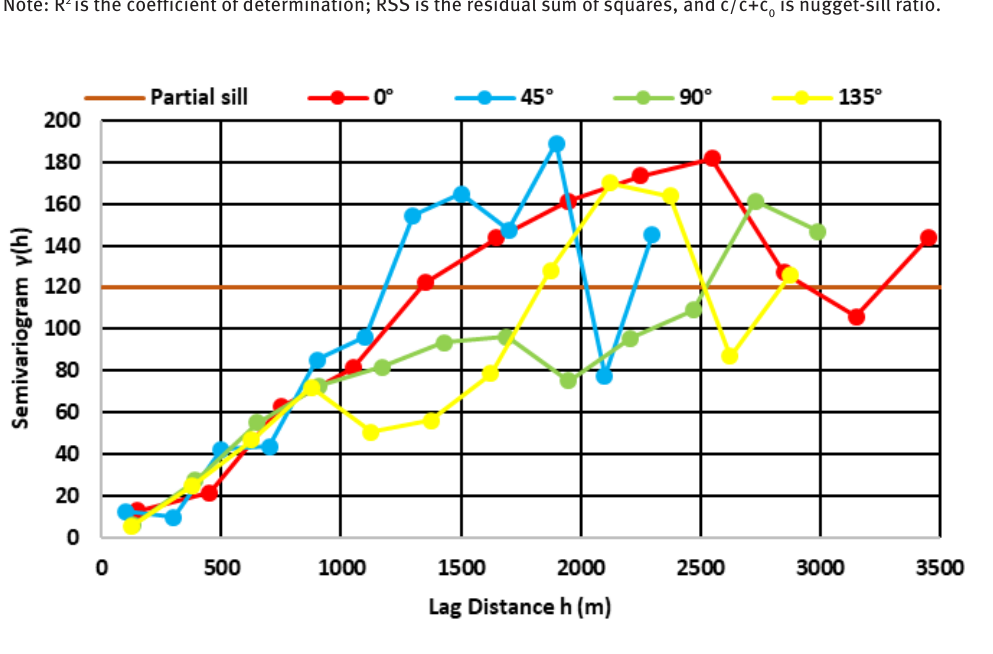
Figure 6: Anisotropic semivariogram of liquefaction potential index variorum for directions 0°, 45°, 90°, and 135°.